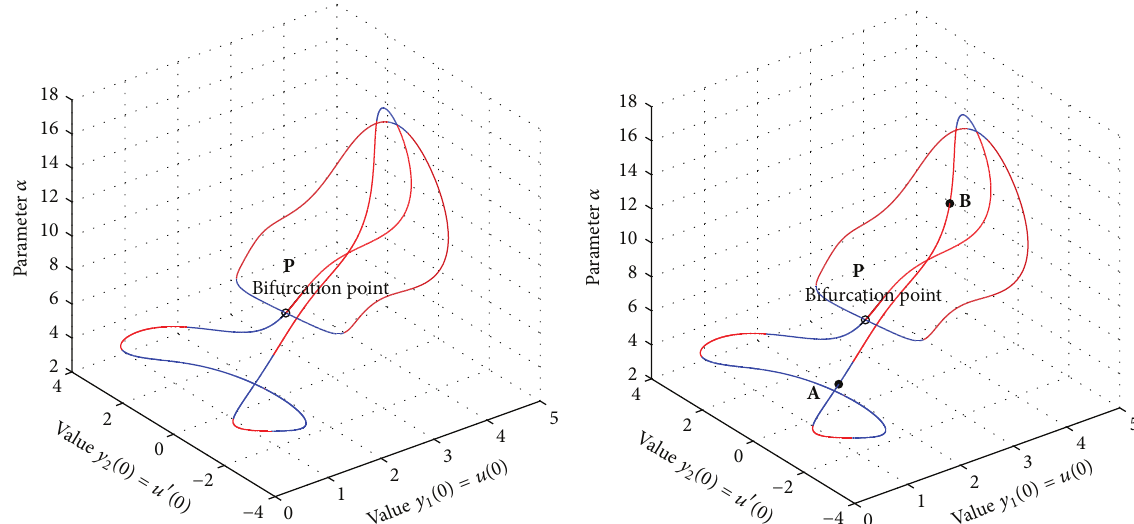
Figure 5: The calculation of bifurcation points depicts the periods of 2𝜋 (blue line) and 4𝜋 (red line) in the left panel and illustrates the stable (blue line) and unstable (red line) curves in the right